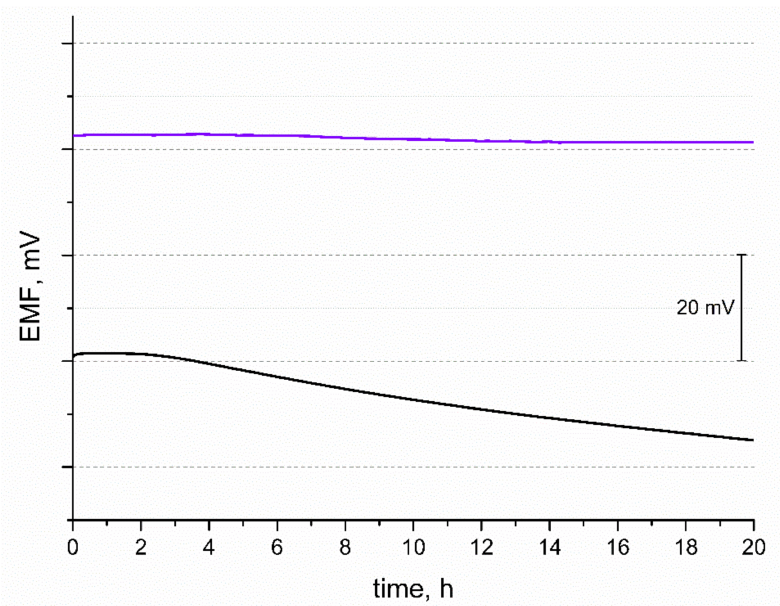
Figure 5. Stability of potentiometric response of GC/IrO 2 · 2H 2 O/K + -ISM (purple line) and GC/K + - ISM electrode (black line) recorded over 20 h in 0.01 M KCl